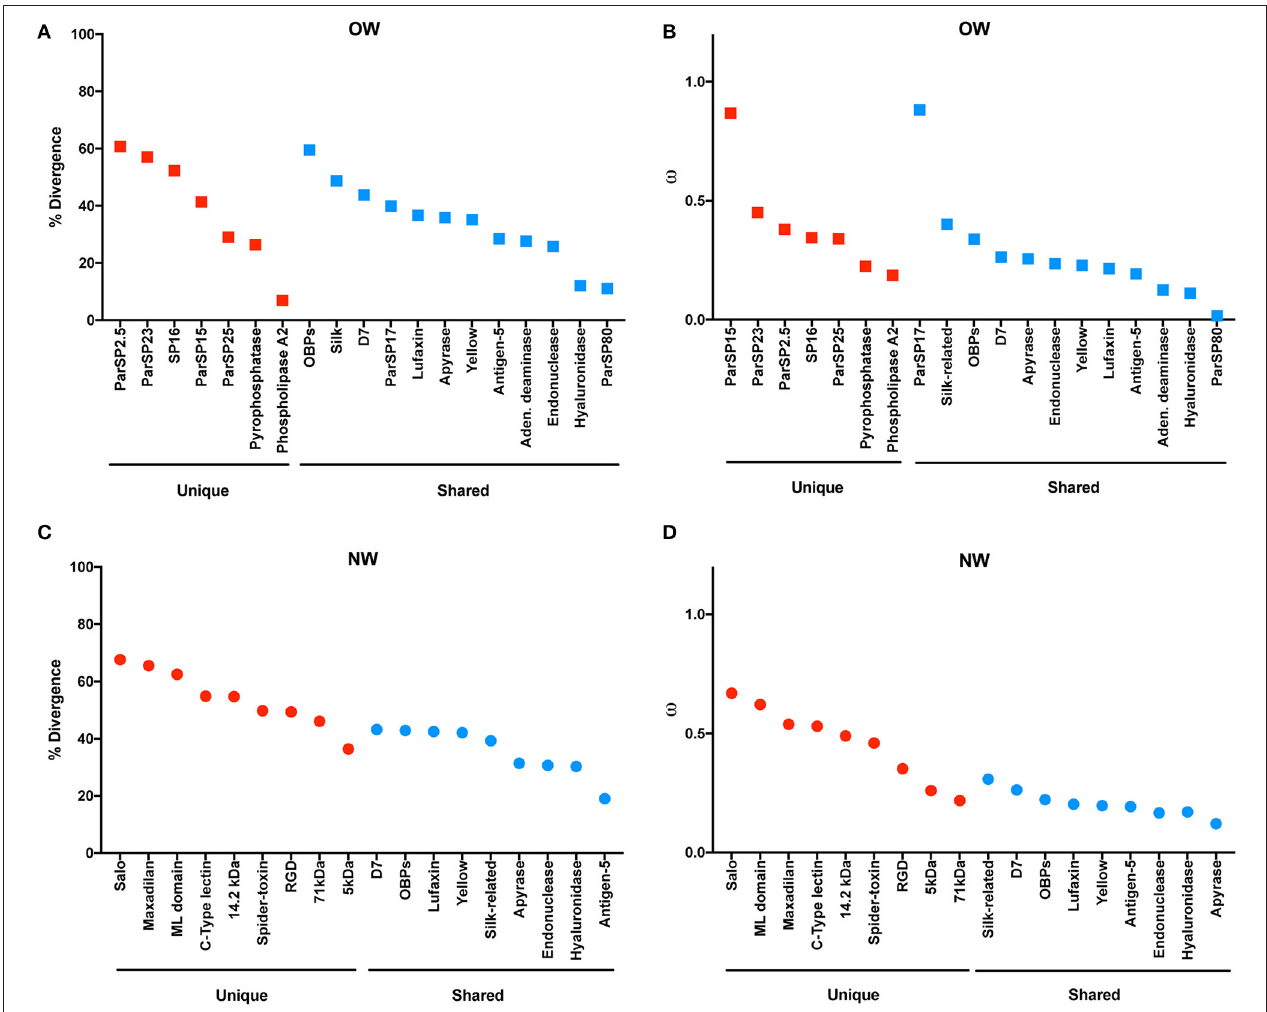
FIGURE 3 | Molecular divergence across salivary protein in Old World (A) and New World (C) sand flies. Rate of non-synonymous over synonymous replacements (omega— ω ) across salivary proteins in Old World (B) and New World (D) sand flies.